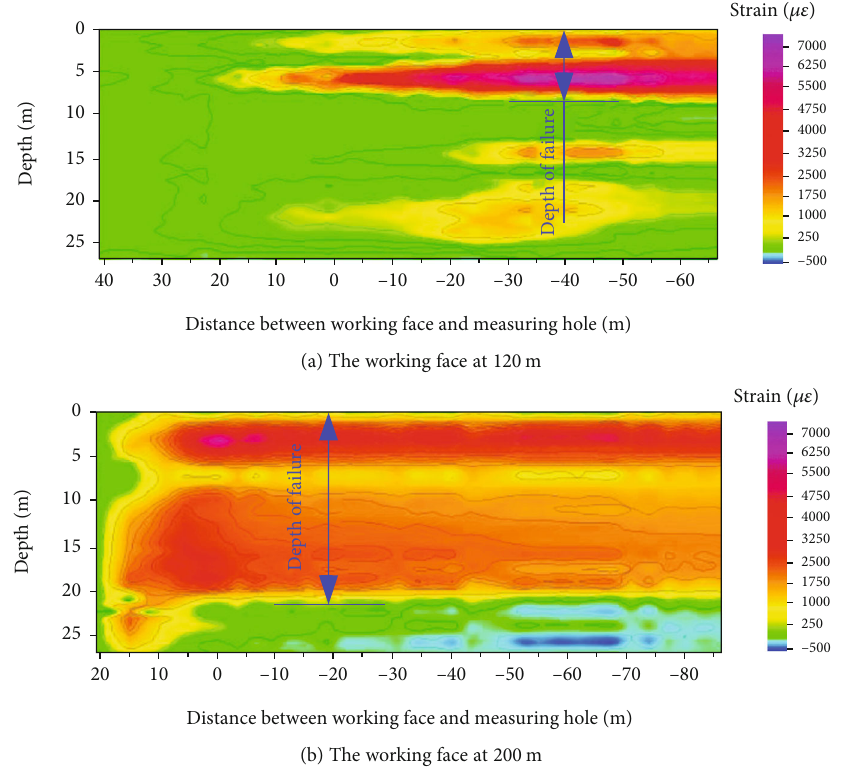
Figure 13: Depth of fl oor failure by the electrical method